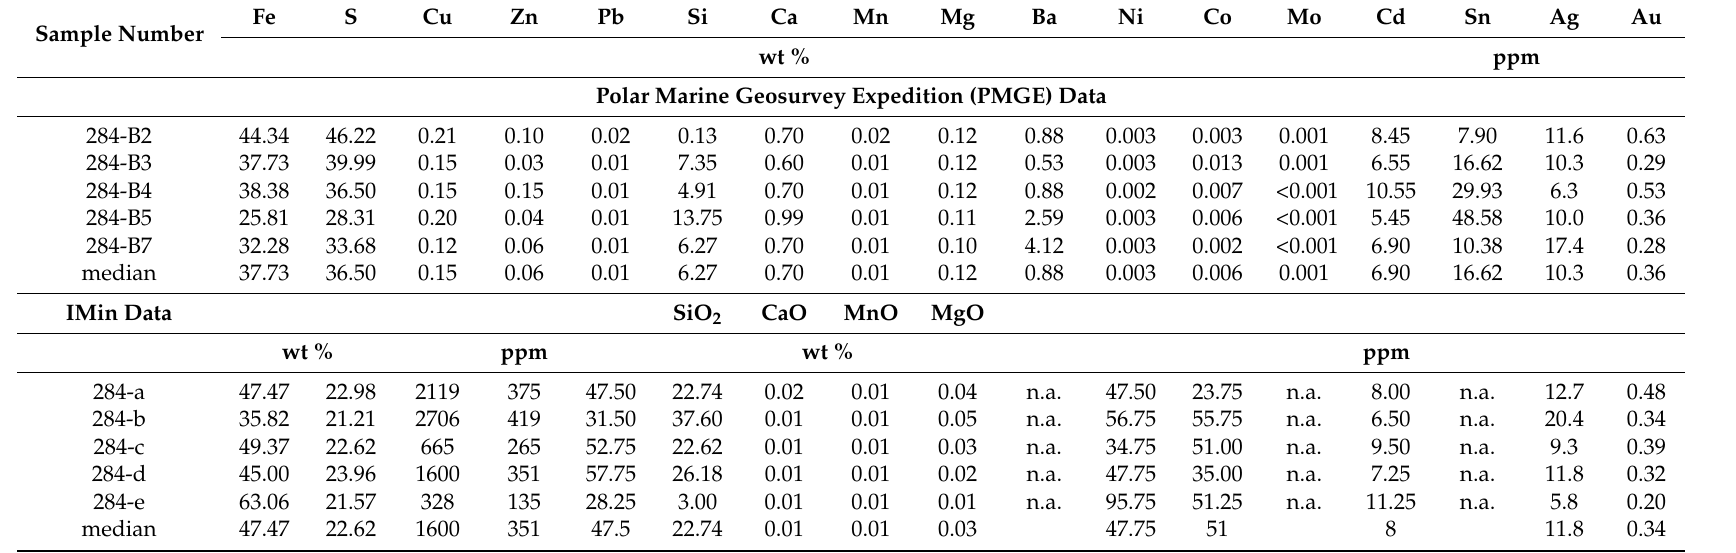
Table 2. Chemical composition of sulfide breccias from the Semenov-3 hydrothermal